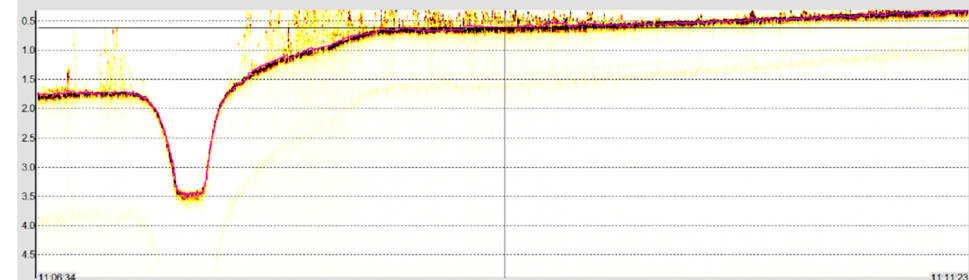
Figure 5. Example of an echogram for a single-beam echosounder with a manually digitized depth (purple line) for a single profile (own elaboration based on conducted measurements).